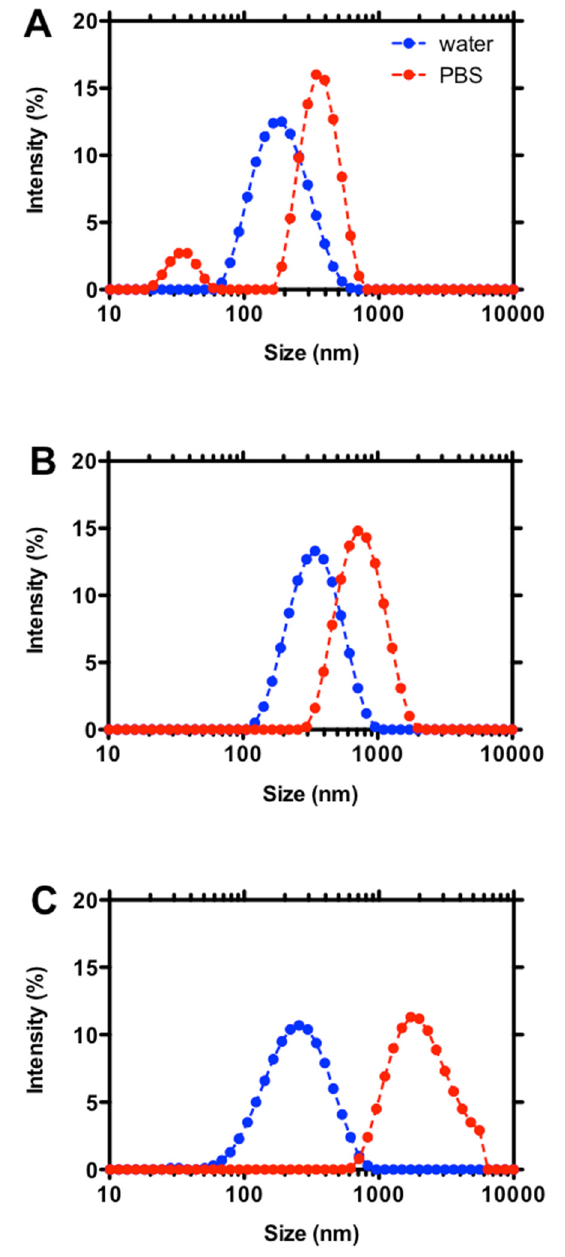
Figure 3. DLS intensity size distribution curves of coacervates composed by F A = 0.16 chitosans at di ff erent molar mass (g / mol): M v = 30,000 g / mol ( A ), 220,000 g / mol ( B ) and 340,000 g / mol ( C ). Coacervates were diluted 1:10 ( v / v ) into two di ff erent media prior to measurements, namely deionized water and PBS.